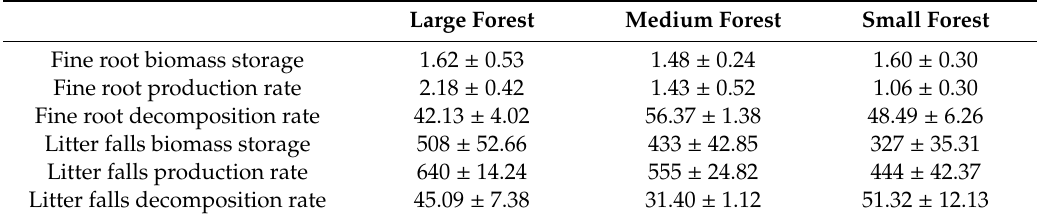
Table 1. Biomass (Mg / ha), production (Mg / ha · y), and decomposition rates (% / y) of fine roots and litter fall among di ff erent forest patches.